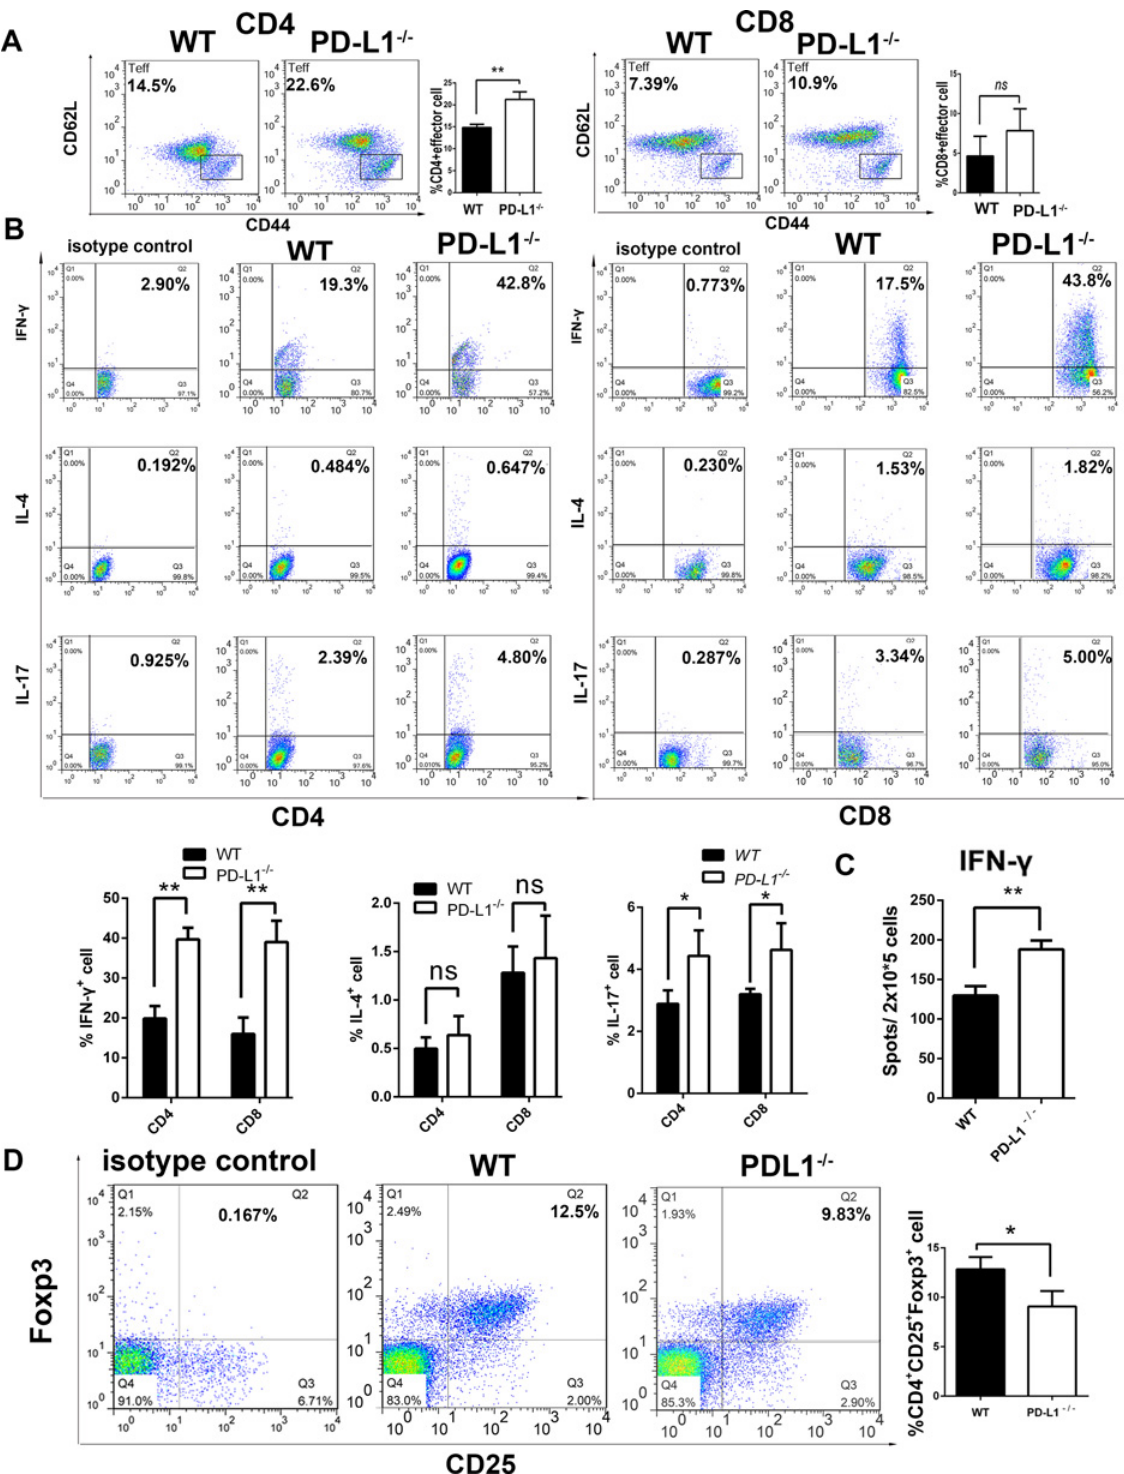
Fig 4. Analysis of effector T-cell, Treg and alloreactive cytokine-producing T cell generation. (A) Flow cytometry analysis of effector CD4 + and CD8 + T T-cell frequency. CD4 + and CD8 + effector T cells were identified by their staining characteristics (CD4 + CD44 high CD62 low and CD8 + CD44 high CD62 low ). The number of CD4 + effector T cells was significantly increased in the splenocytes harvested from recipients that had been transplanted with PDL1- deficient islet allografts. However, the number of CD8 + effector T-cells was not of a significant difference between the two groups. (B) Frequency of alloreactive